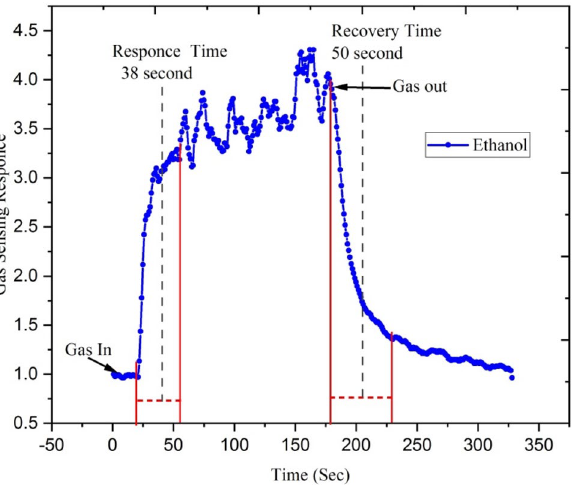
Figure 14. Response-recovery characteristics of the Ga-doped ZnO (Ag 9+ ion irradiated at 5 × 10 13 ion fluence) thin film at the operating temperature 500 °C with 250 ppm concentration of